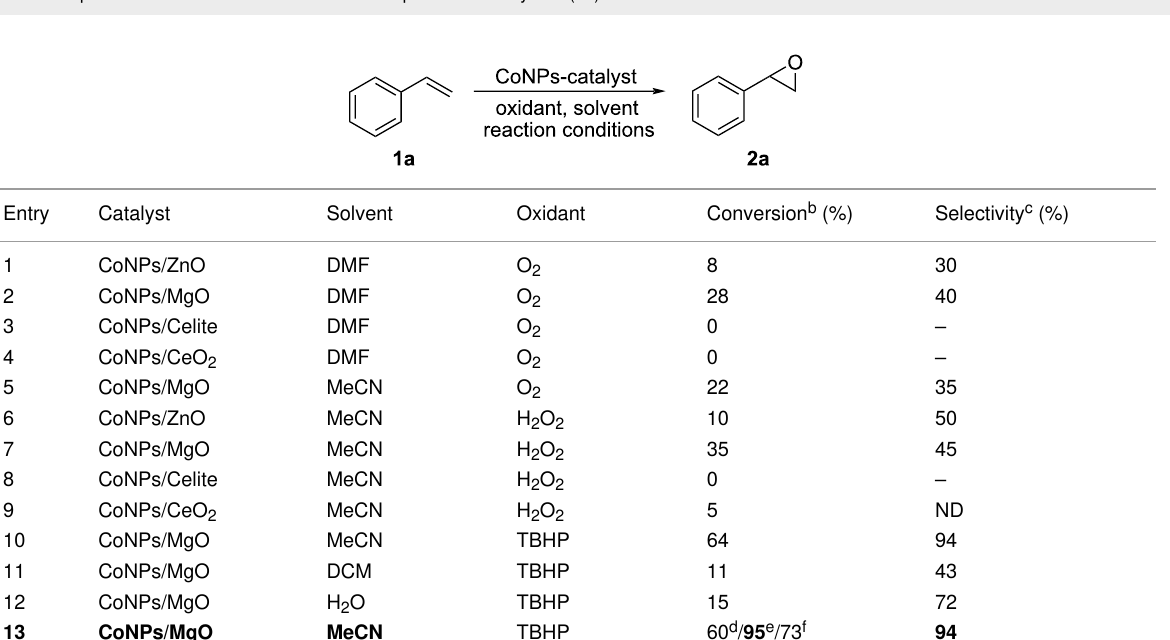
Table 1: Optimization of reaction conditions for the epoxidation of styrene ( 1a ).